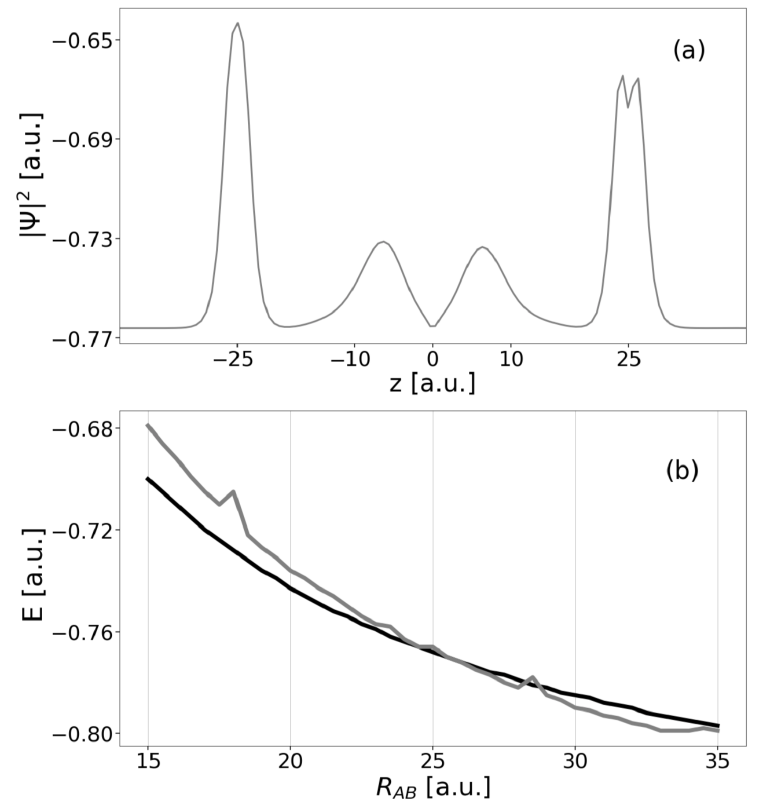
Figure 11. ( a ) Density | Ψ | 2 of the three-electron shape-resonance AB ∗ A ∗ (grey) at R AB = 25a.u. and ( b ) its state energy E (grey) compared to the energy of the initial electron DE state A ∗ BA ∗ (black) as function of R AB